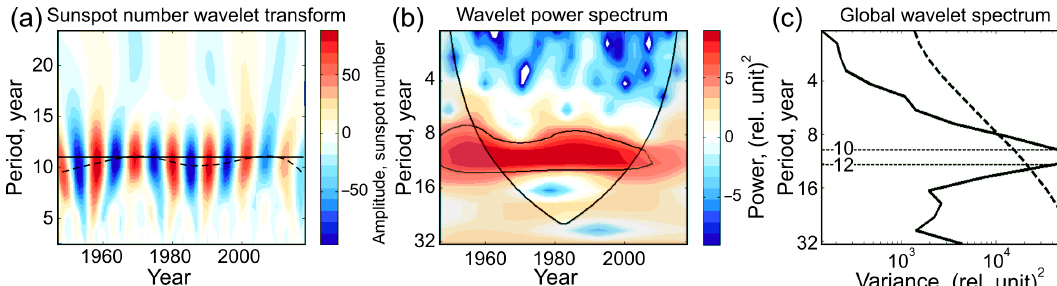
Figure 4. ( a ) The wavelet transform with the real part of the Morlet function for sunspot number time series in 1947–2018; red (blue) shows the location of the maxima (minima) of the solar cycle signal in the coordinates ‘year–period’; solid line marks a period of 11 years and a black dashed curve is drawn through the peak intensities of the wavelet transform. ( b ) Power spectrum of the wavelet transform shown in ( a ) and the solid curve is the cone of influence, within which the spectrum is not significantly influenced by boundary e ff ects. ( c ) Global wavelet spectrum for ( b ). Contour in ( b ) and dashed curve in ( c ) show the 95% confidence level with the red-noise background spectrum calculated for a lag-1 autocorrelation of 0.7. The cone of influence is shown as a lighter shade. Wavelet transform with the mother wavelet ψ ( t ) = e − t 2 /2 · e i · 6 t is used. Dashed horizontal lines in ( c ) mark the peak power in the global wavelet spectrum between the periods of 10 and 12 years. Note the di ff erence in scale for periods in ( b ) and ( c ) from ( a ).